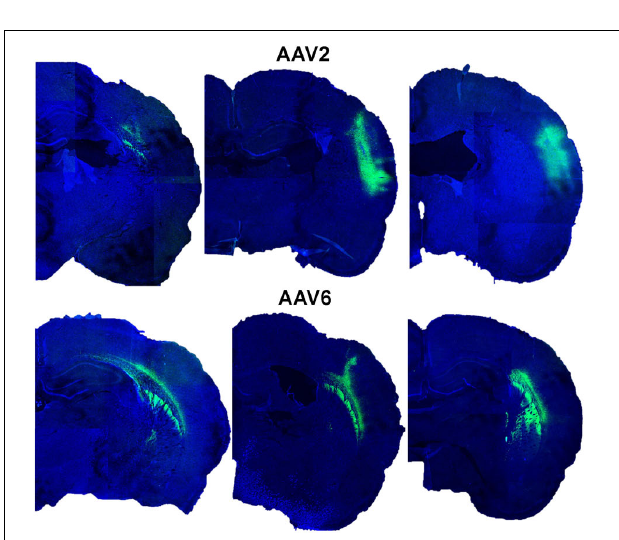
to ensure that they were fully functional. Retinal epithelial cells